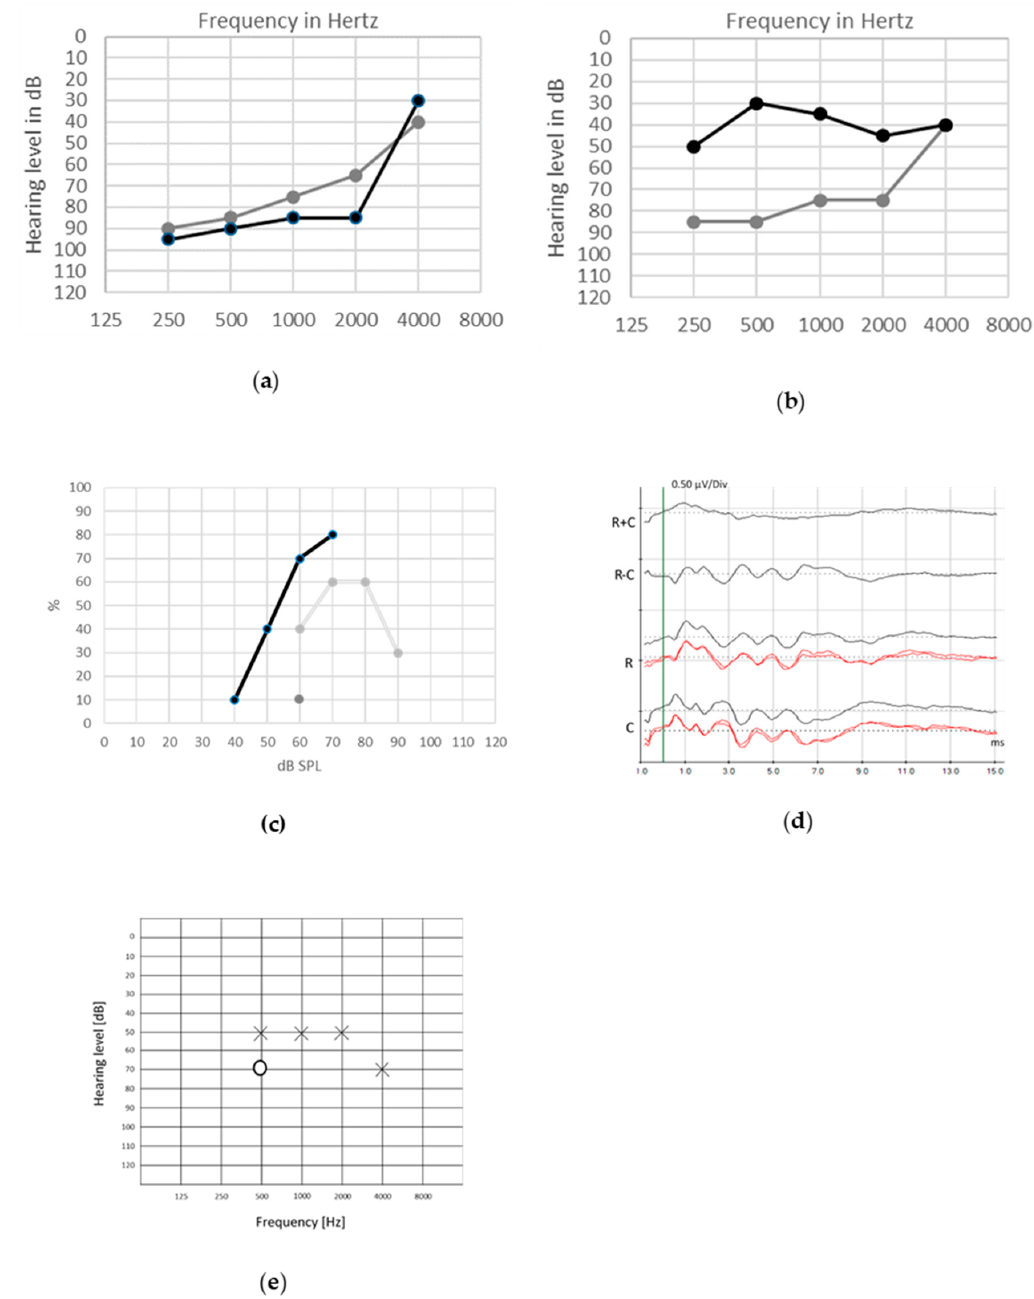
Figure 2. Audiological assessment in 8-year-old patient with CAPOS syndrome. CAPOS is an acronym for Cerebellar ataxia, Areflexia, Pes cavus, Optic atrophy and Sensorineural hearing loss. Unaided pure tonal thresholds in both ears are shown in ( a ). The tonal hearing thresholds remain poor in the right ear aided by an acoustical hearing aid (( b ), gray line) but are clearly improved in the left ear by cochlear implant (( b ), black line). Speech perception was poor in unaided condition (( c ), 10% gray dot at 60dB), it was partially improved by acoustical hearing aids (( c ), gray line) but became significantly better with cochlear implant (( c ), black line). abnormal auditory brainstem responses (ABRs) ( d ) show the responses evoked by clicks presented in rarefaction (R) and condensation (C) phase and the subtraction of R and C (R − C), highlighting the cochlear microphonic (CM) and the lack of waves V in the summation (R + C). Auditory steady-state responses (ASSRs) thresholds ( e ) are present in the left (X) more than in the right (O) ear.